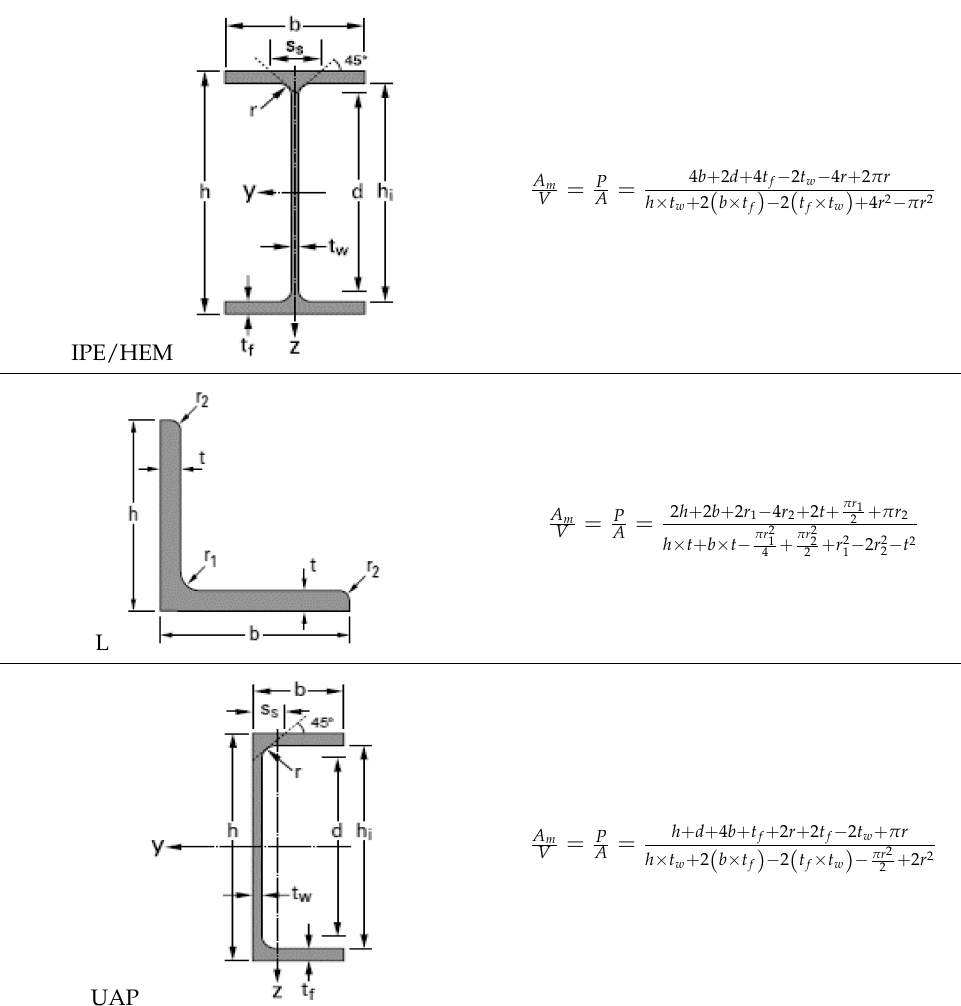
Table 2. Expressions used to calculate the section factors of IPE/HEM, L, and UAP, m − 1